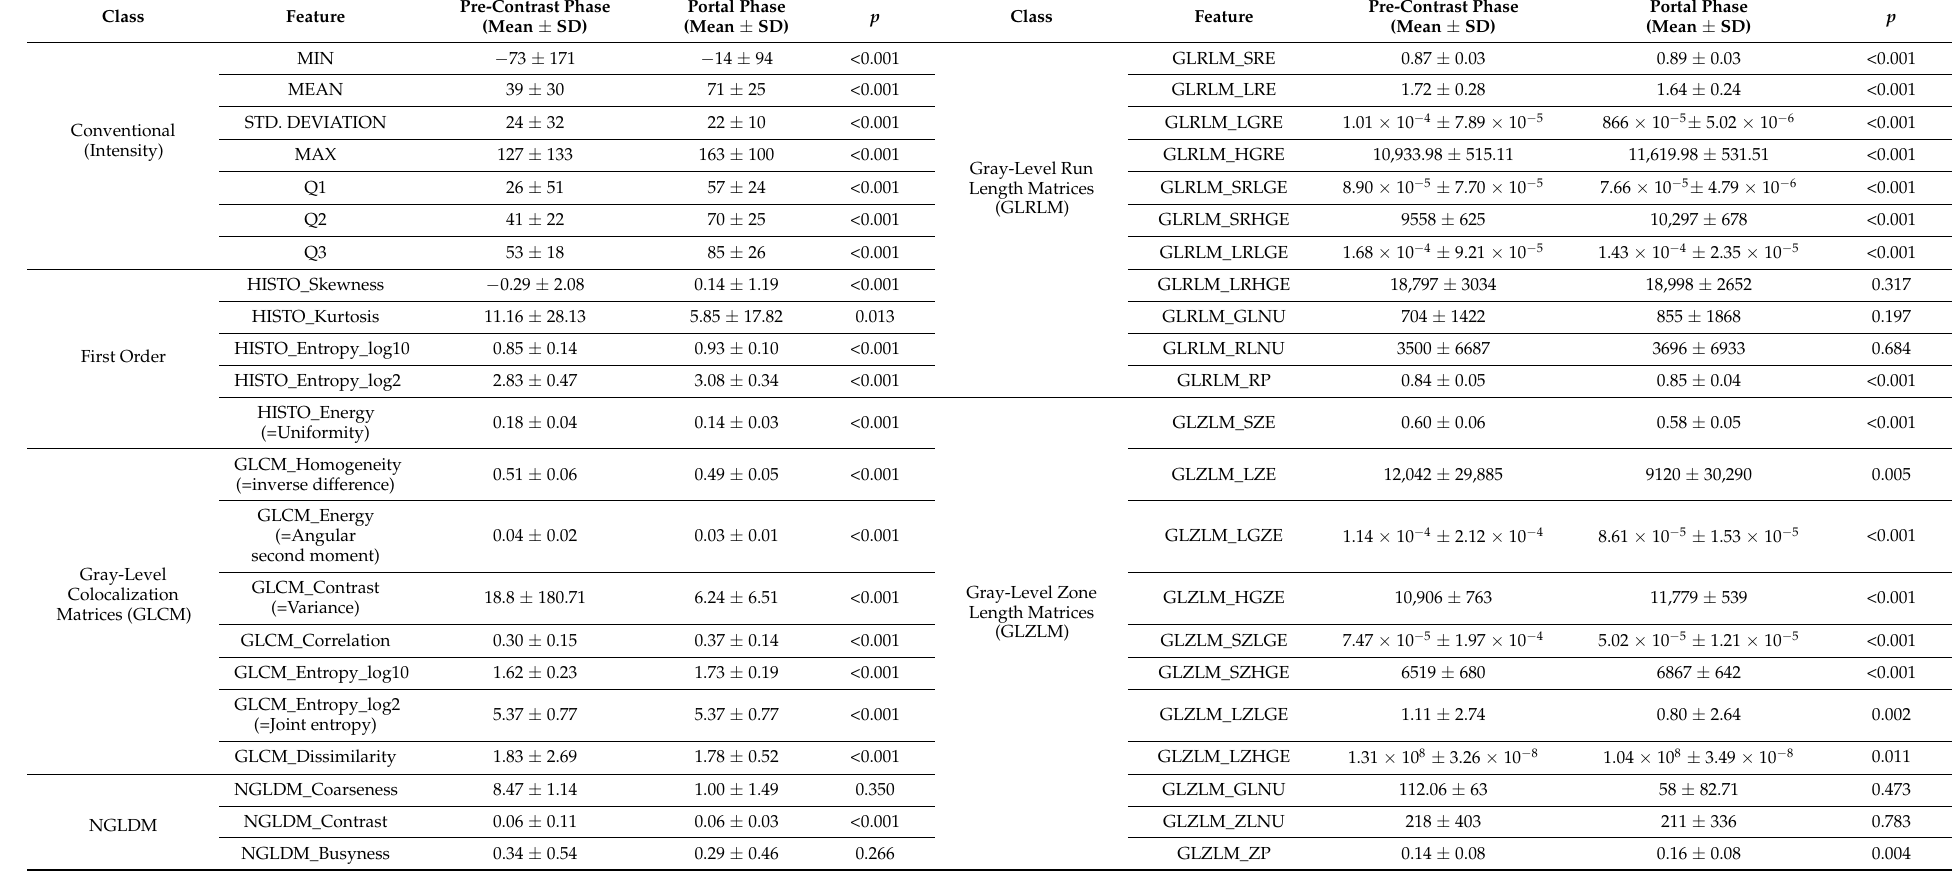
Table 2. Values of the radiomics features of Tumor volume of interest (VOI) in the portal and pre-contrast